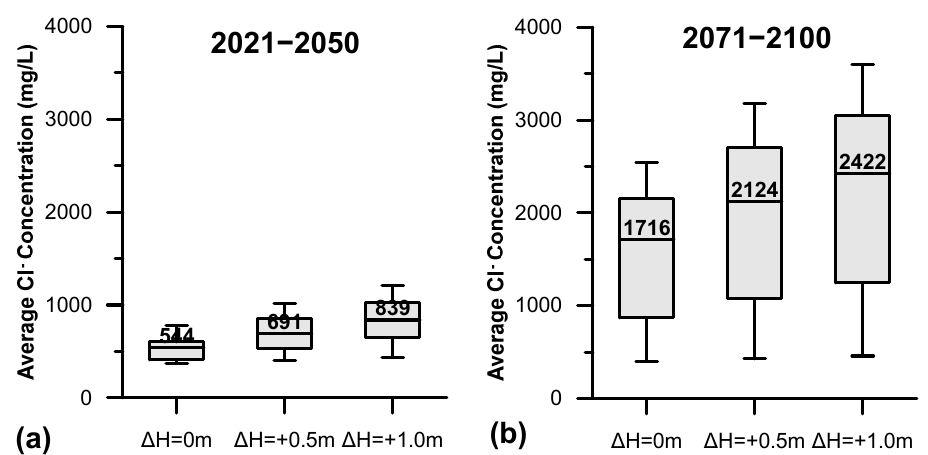
Figure 8. Boxplots presenting the annual variation of groundwater Cl − concentration for the periods ( a ) 2021–2050 and ( b ) 2071–2100 under no sea level rise ( Δ H0), sea level rise of 0.5 m ( ΔΗ 0.5) and sea level rise of 1 m ( ΔΗ 1).